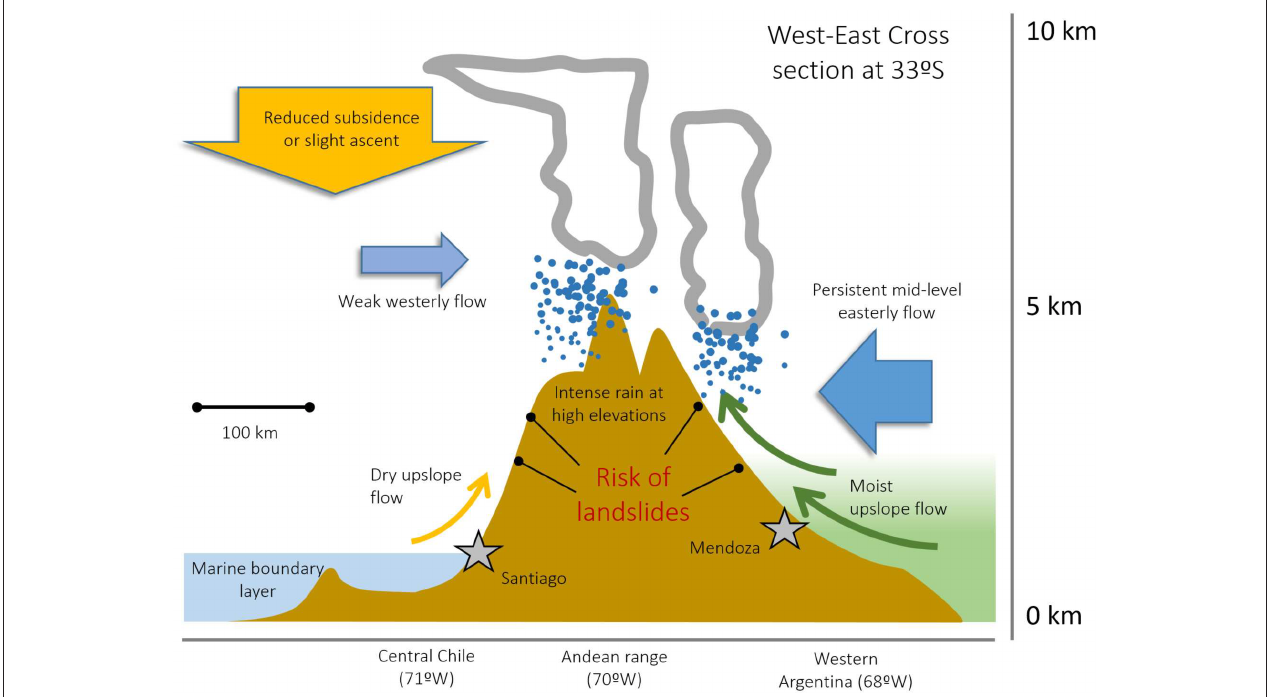
FIGURE 9 | Schematic west-east cross section during summer storms over the extratropical Andes (30-37 ◦ S). This is the most frequent type of storm (2/3) associated with an approaching weak trough aloft and easterly winds over the Argentinean side. Adapted from Viale and Garreaud